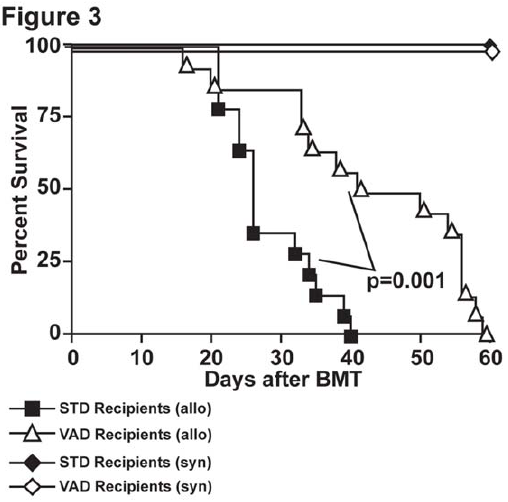
Figure 3. Vitamin A deficiency in HSCT recipients prolongs survival but does not protect from lethal GvHD. After lethal irradiation, STD BALB/c or VAD BALB/c recipients received 5 6 10 6 C57BL/6 T cell depleted bone marrow cells supplemented with 1 6 10 6 T cells (N=14/group). STD BALB/c or VAD BALB/c recipients that received syngeneic (BALB/c) grafts were used as controls (N=4/group). Data are combined from two independent experiments.